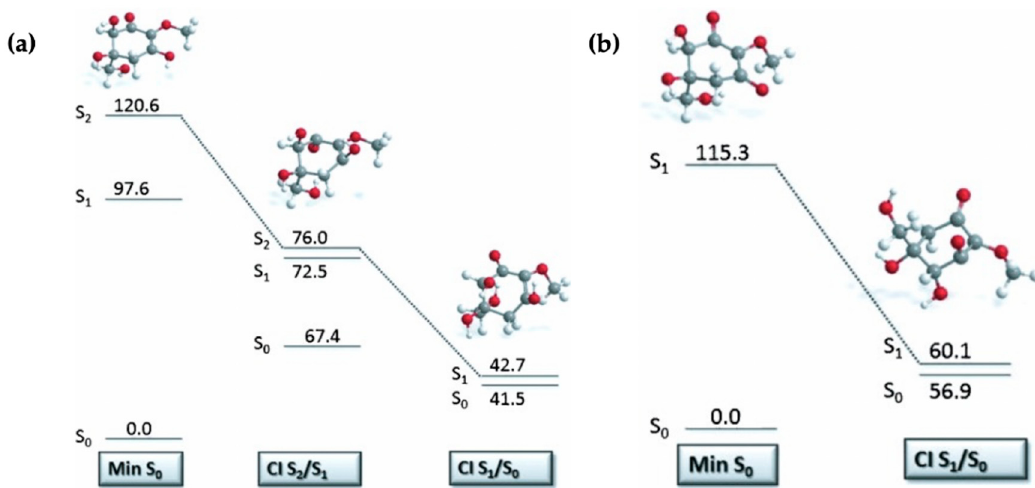
Figure 12. Critical points along the MEP for ( a ) gadusol and ( b ) gadusolate computed by Losantos et al. [87] where the energies are reported in kcal mol − 1 relative to the electronic ground-state minimum. Reproduced and adapted with permission from [87], licensed under CC BY-NC-ND 4.0. © 2015 The Authors. Published by Wiley-VCH Verlag GmbH & Co. KGaA.